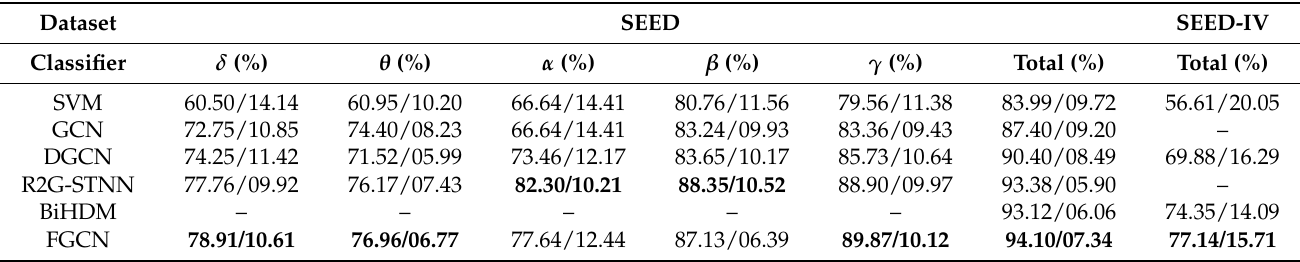
Table 1. The accuracy and standard deviation on SEED and SEED-IV with DE features. The best results are marked in